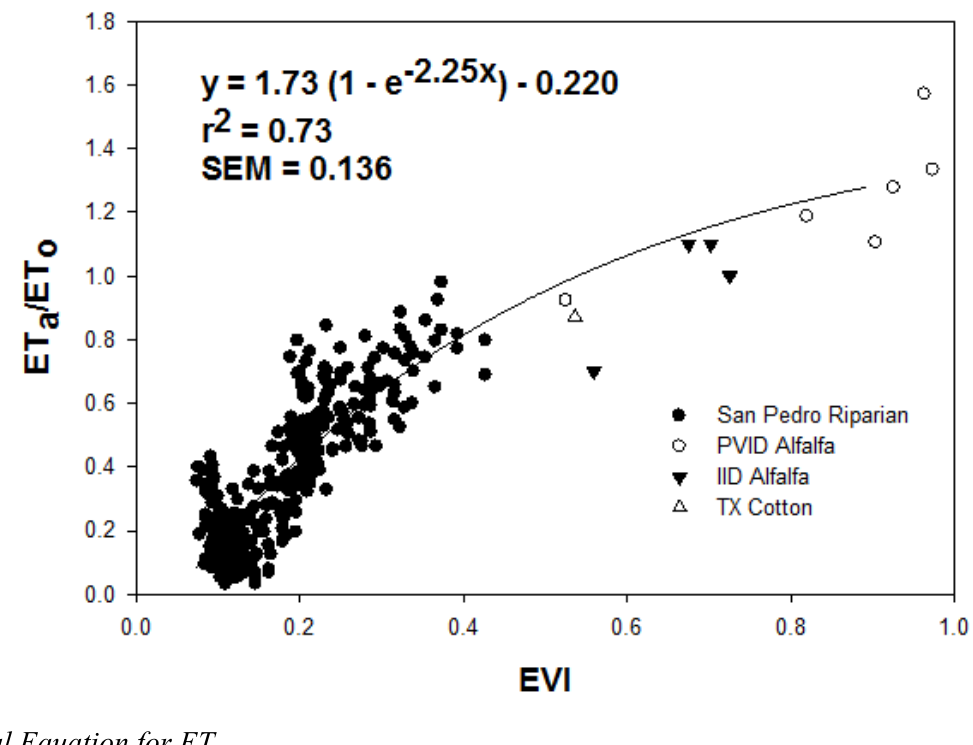
Figure 4. ET /ET vs. EVI for San Pedro moisture flux tower sites used in model a o calibration and alfalfa measured by moisture flux towers in the Palo Verde (PVID) and Imperial (IID) irrigation districts and for cotton measured by neutron hydroprobe soil water balance in Bushland, Texas (TX